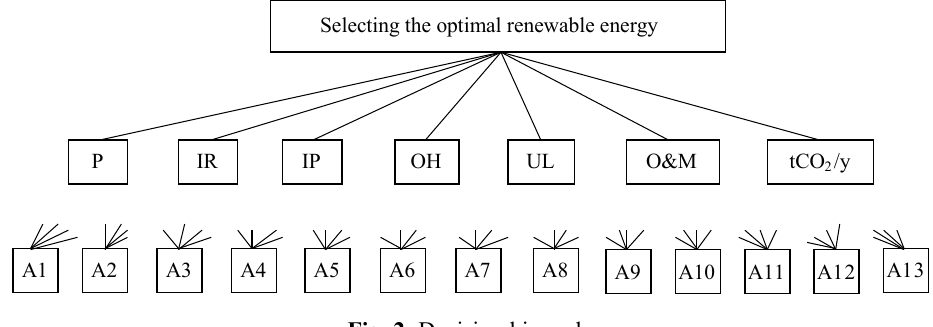
Fig. 2. Decision hierarchy